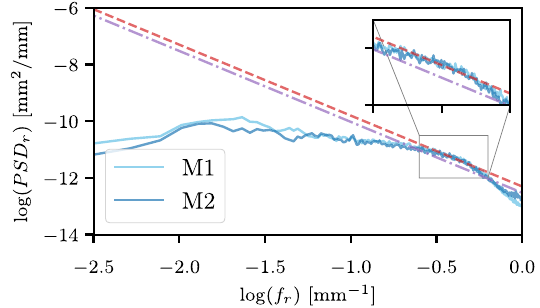
FIG. 4. Radial PSD of the (light blue) M1 and (dark blue) M2 parabolic mirrors as function of the spatial frequency f measured over the useful corona with the specified (red- dashed) upper-limit and (violet-dash-dotted) lower-limit lines. Courtesy of SAFRAN-REOSC.